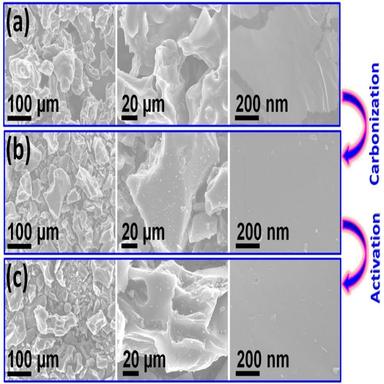
SEM images at different magnifications of (a) Jujube fruit powder, (b) JC and (c) JPC material.